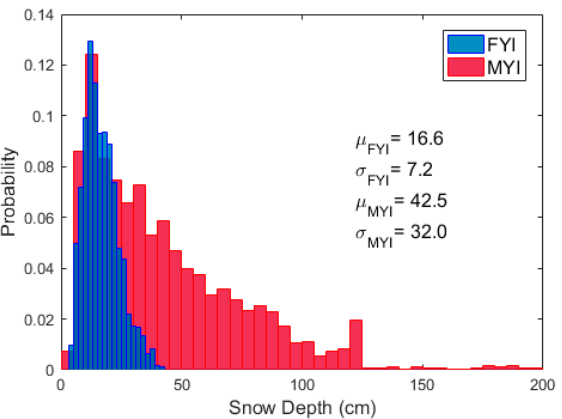
Figure 13. 2016 snow depth distributions on FYI (blue) and MYI (red) near Eureka in the CAA. Mean ( µ ) and standard deviations ( σ ) are given by ice type. 1792 measurements snow depth measurements were collected on FYI and 1810 measurements on MYI.